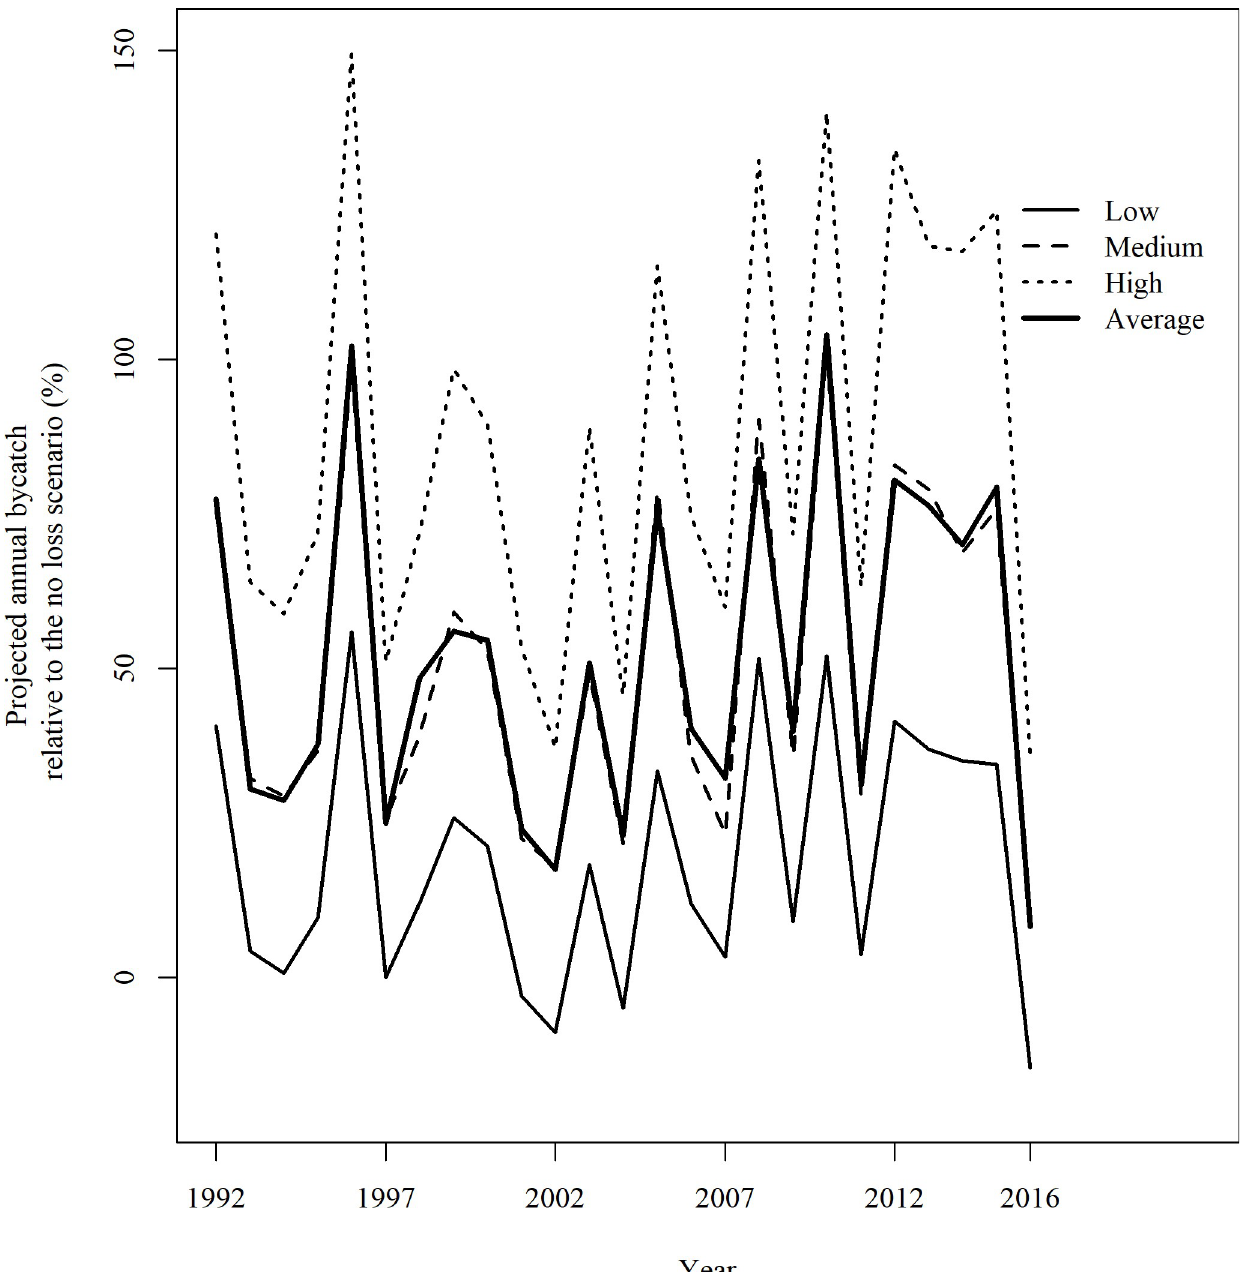
Fig 7. Relative differences in annual bycatch between different bycatch loss scenarios and the loss-free model.